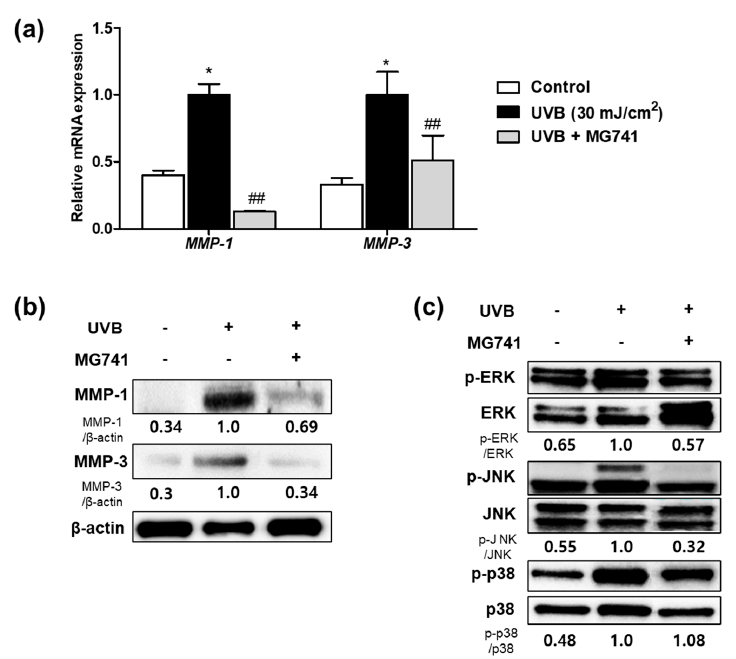
Figure 3. The mRNA and protein expression of matrix metalloproteinases (MMPs) and mitogen- activated protein kinases (MAPKs) in CFS from Bi. lactis MG741 treatment with UVB-exposed Hs68 fibroblasts. ( a ) The mRNA expression levels of MMPs in UVB (30 mJ/cm 2 )-exposed Hs68 fibroblasts treated with CFS (10%) from Bi. lactis MG741. ( b , c ) The Western blot images were measured following treatment with CFS and UVB. Fibroblasts were treated with CFS (10%) Bi. lactis MG741 for 24 h. Subsequently, the cells were exposed to UVB (30 mJ/cm 2 ) and it was further cultured in media containing CFS for 48 h for MMPs, and 24 h for MAPKs. The ratio of each protein was shown below the blotting images and indicated to fold of UVB-exposed control. Data are indicated as means ± SE ( n = 3). * p < 0.05 vs. no-UVB control; ## p < 0.01 vs. UVB-exposed control. 3.3. Bi. lactis MG741 Modulates Skin Changes on UVB-Exposed Dorsal Skin of HR-1 Mice